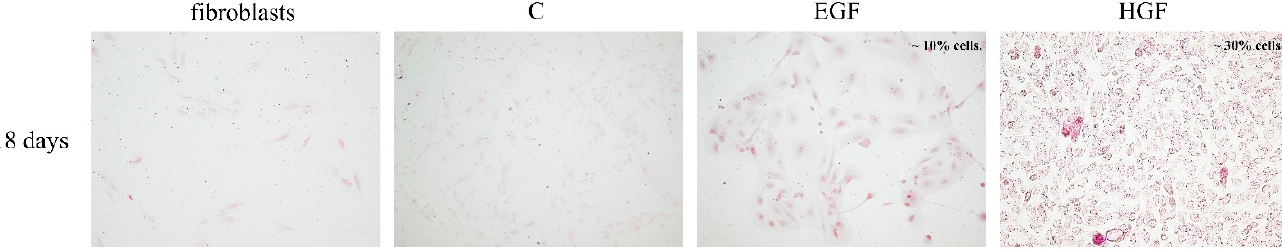
Figure 7. Detection of such glycogen presence in the test groups (PAS reaction). The colour reaction was positive in the EGF and HGF groups and negative in fibroblasts (negative control) and control hAECs (C). Magnification 100×.